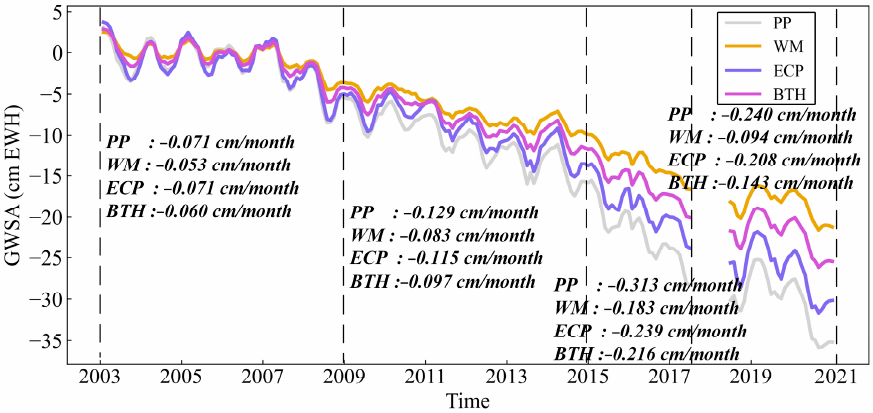
Figure 9. The GWSA trends in different subregions over time; PP, ECP, WM, BTH represent the piedmont plain, eastern central plains, western mountainous area, and the entire study area, respectively.